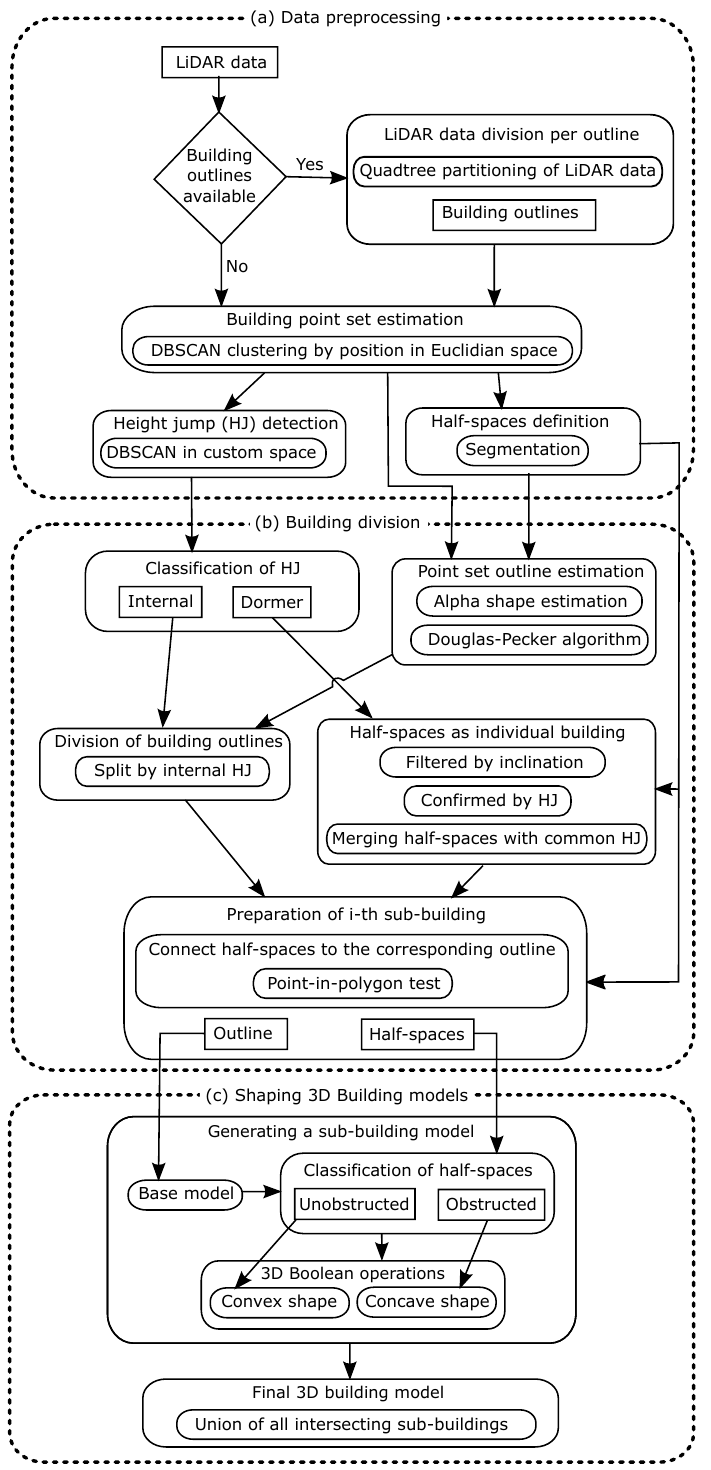
Figure 1. Workflow of the proposed methodology: data preprocessing ( a ), building division ( b ) and shaping 3D building models ( c